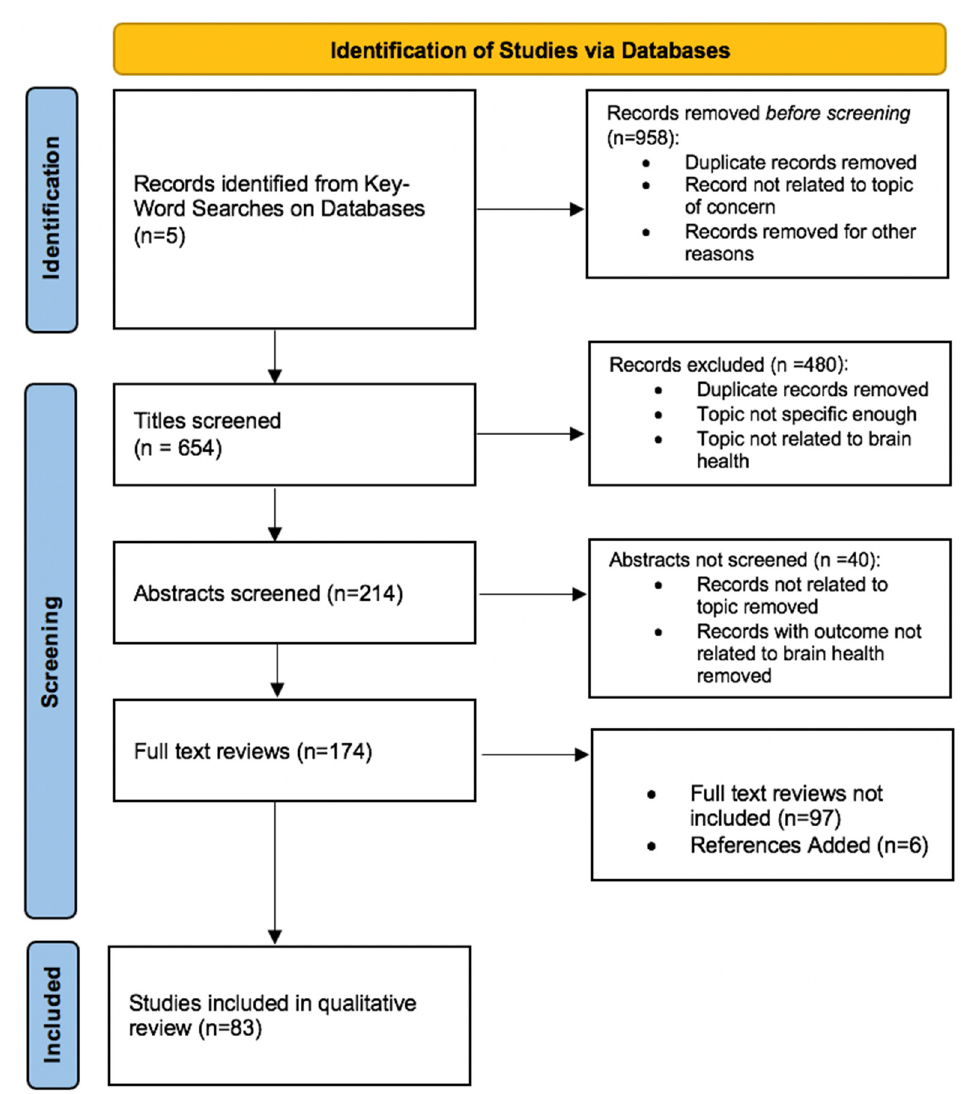
Figure 1. Derivation of literature reviewed: A literature search was conducted through key-word searches on databases that culminated in the inclusion of 83 studies in the qualitative review.